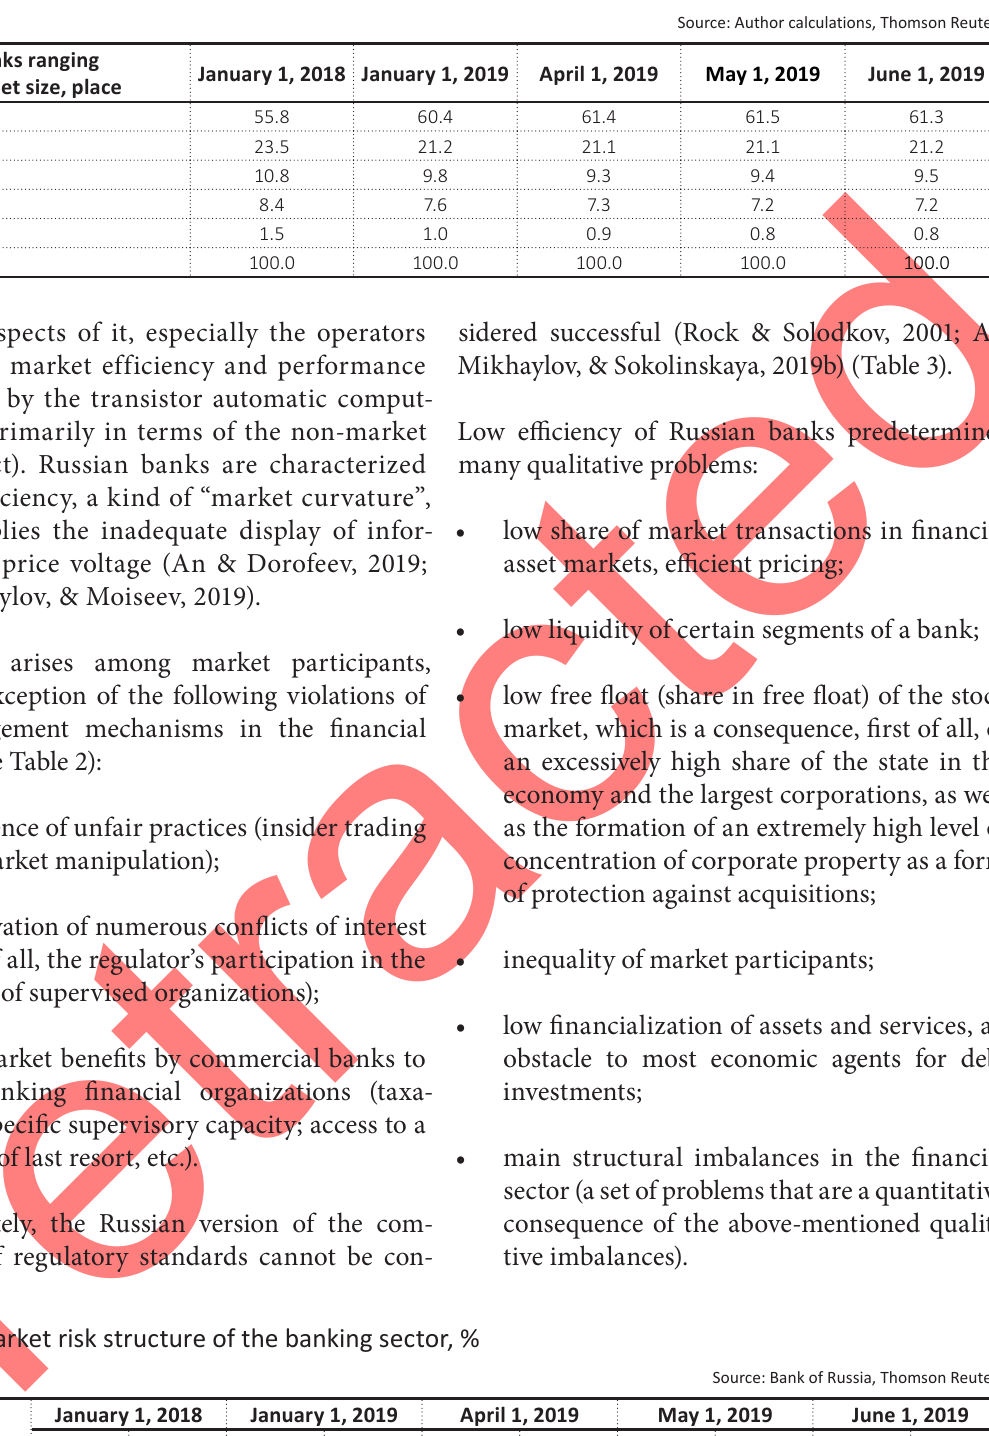
Table 1. Asset concentration in the banking sector of Russia, %